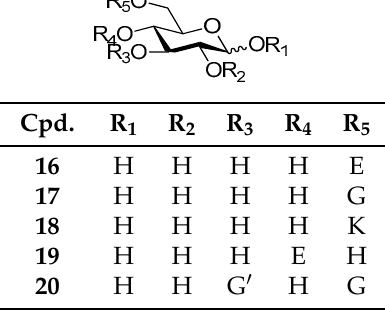
Figure 4. Structures of compounds 16 – 20 . Molecules 2016 , 21 , 1402